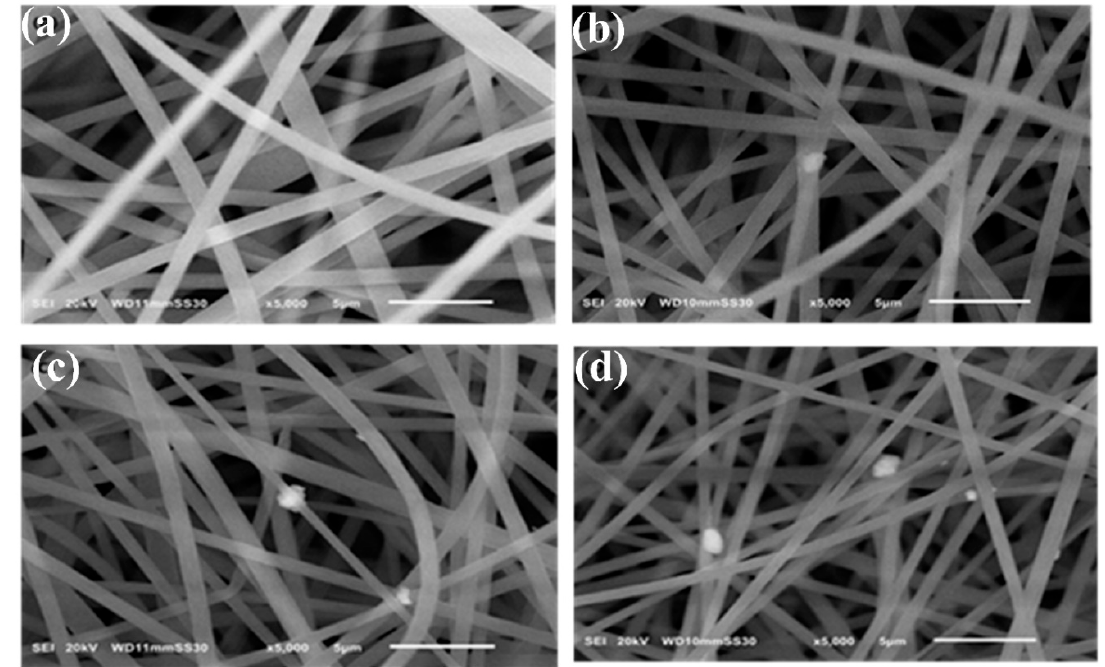
Figure 3. SEM images: ( a ) Blank PS membrane ( b ) Composite PS/GNPs membrane with 0.25 wt.% ( c ) Composite PS/GNPs membrane with 0.5 wt.% ( d ) Composite PS/GNPs membrane with 0.75 wt.%.